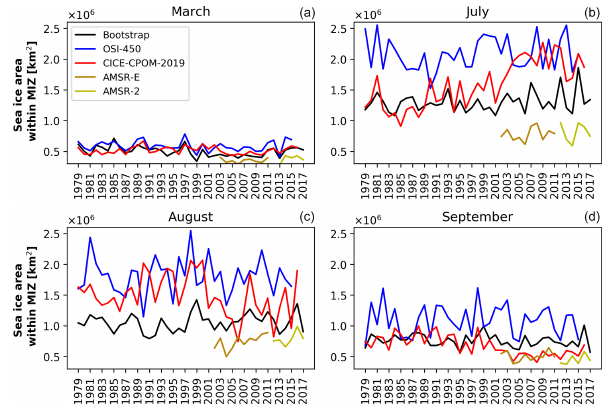
Figure 4. Time series of sea ice area within the MIZ; monthly aver- ages are taken from daily